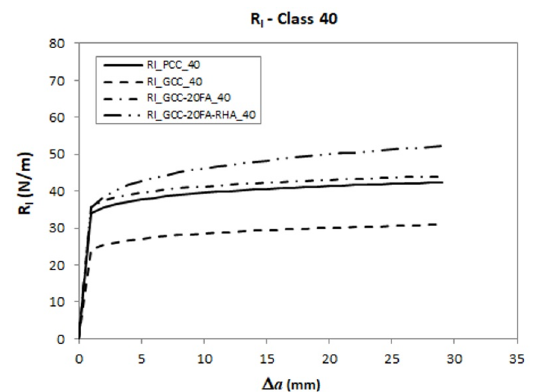
curves with the extension of the Figure 9. Variation of the R I crack for notched beams of concrete strength class of 40 MPa, with different